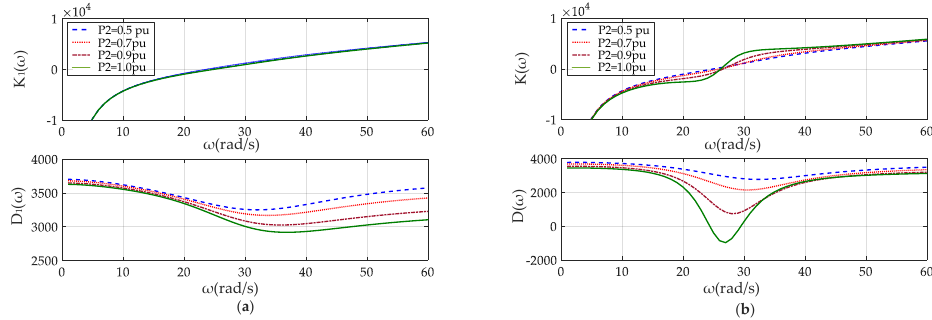
Figure 8. Frequency response curves of spring and damping coefficients under different VSC2 power outputs for ( a ) individual VSC1, ( b ) the entire system.